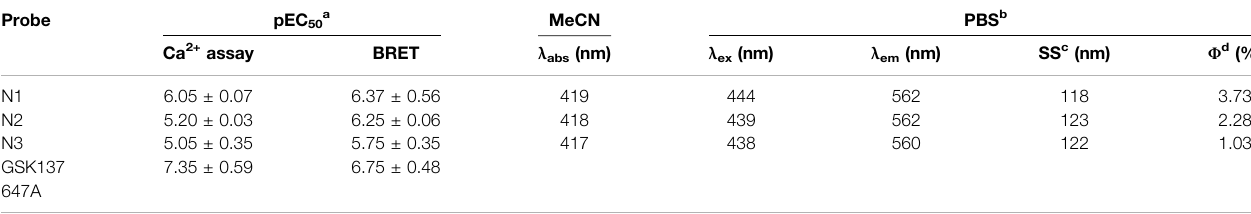
TABLE 1 | Spectroscopic properties and pharmacological properties of our fl uorescent probes.